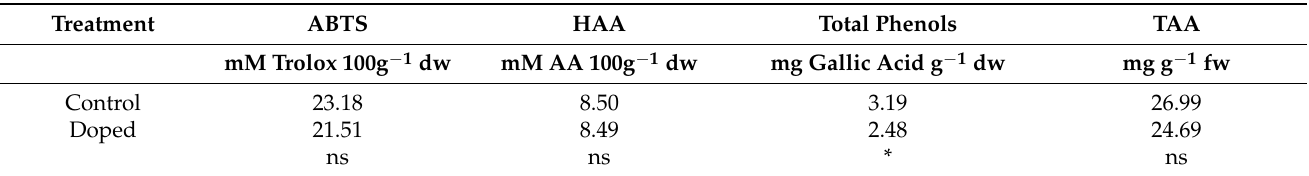
Table 4. Hydrophilic antioxidant activity (HAA), ABTS antioxidant activity (ABTS), phenolics, and total ascorbic acid (TAA) of lettuce leaves in greenhouse as affected by the cover